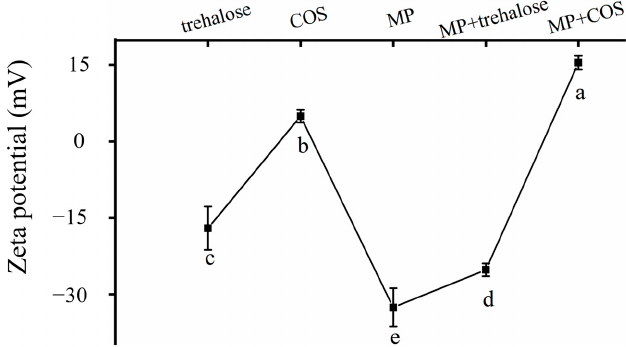
Figure 3. Zeta potential of trehalose, COS, MP, MP + trehalose, and MP + COS.